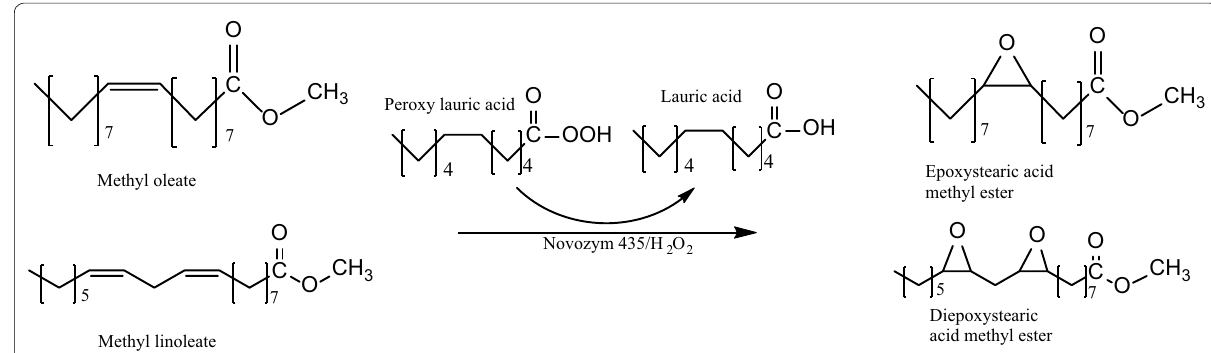
Fig. 3 Reaction mechanism of epoxystearic and diepoxystearic acid methyl ester from methyl oleate and methyl linoleate